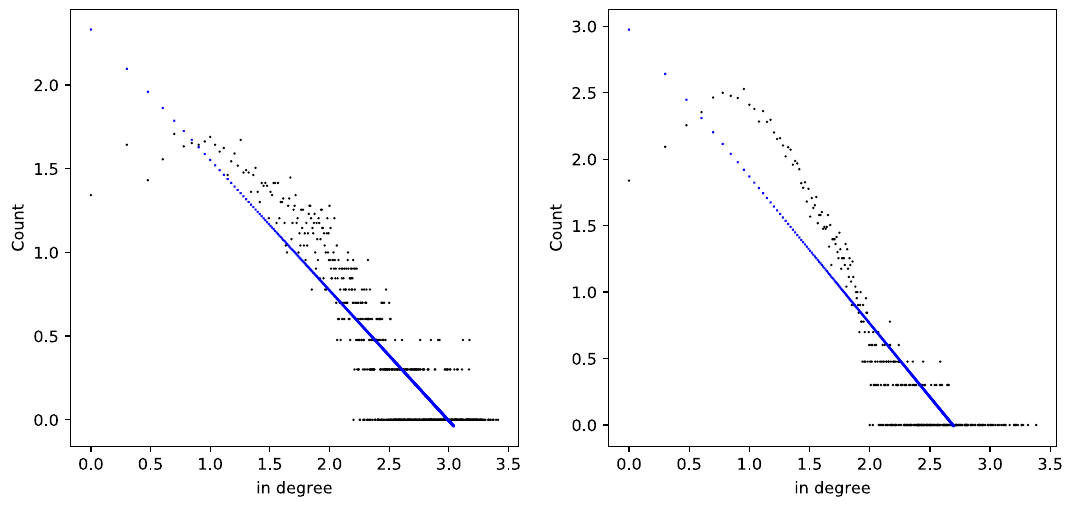
Figure 4: In - degree distributions for 2008 ( left ) and 2019 ( right )